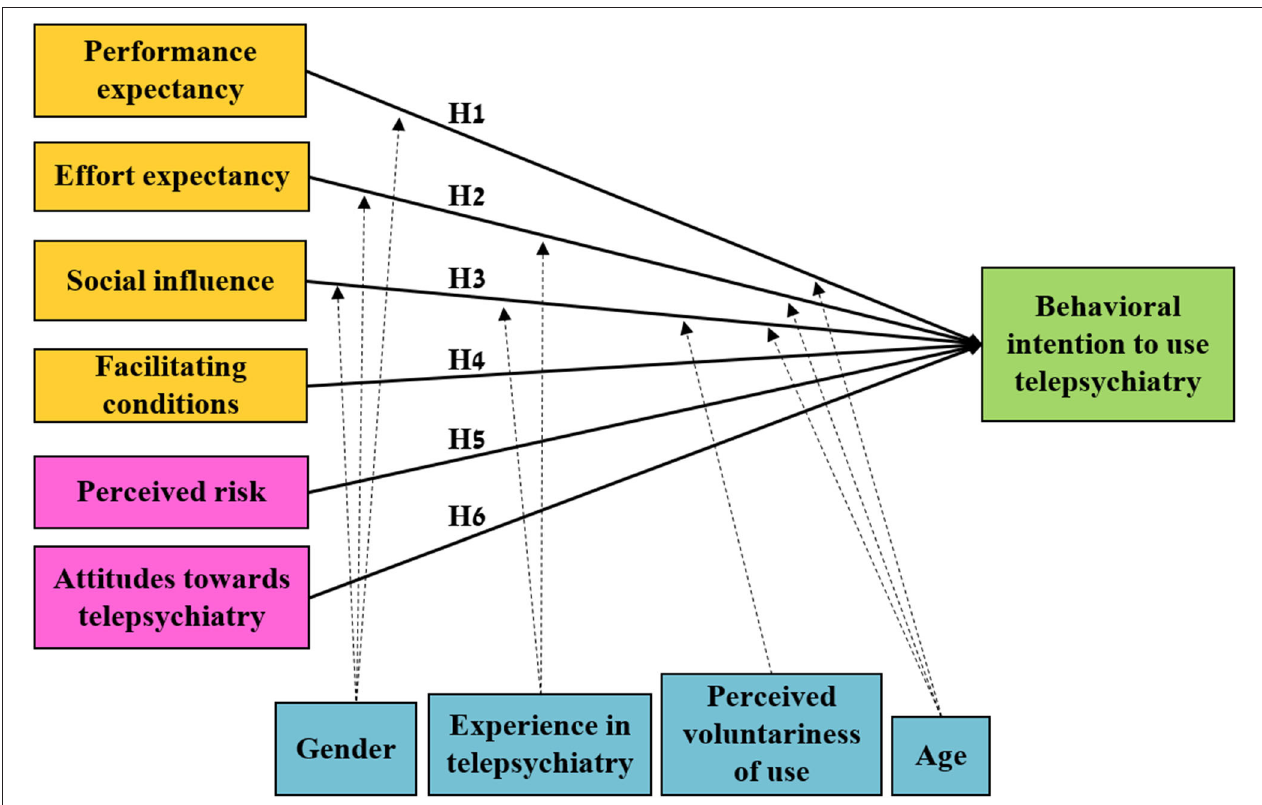
FIGURE 1 | An illustration of the modified UTAUT model used in the study. The model is similar to the UTAUT model, except for the addition of the perceived risk and attitudes toward telepsychiatry variables. Orange and pink—independent variables, blue—confounding variables (covariables), green—dependent variable.